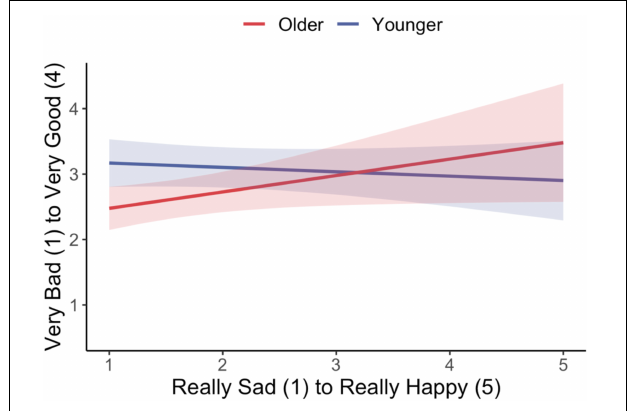
FIGURE 4 | Interaction of Age and Emotion rating for the child who received less. Shaded bands represent 95% CIs.